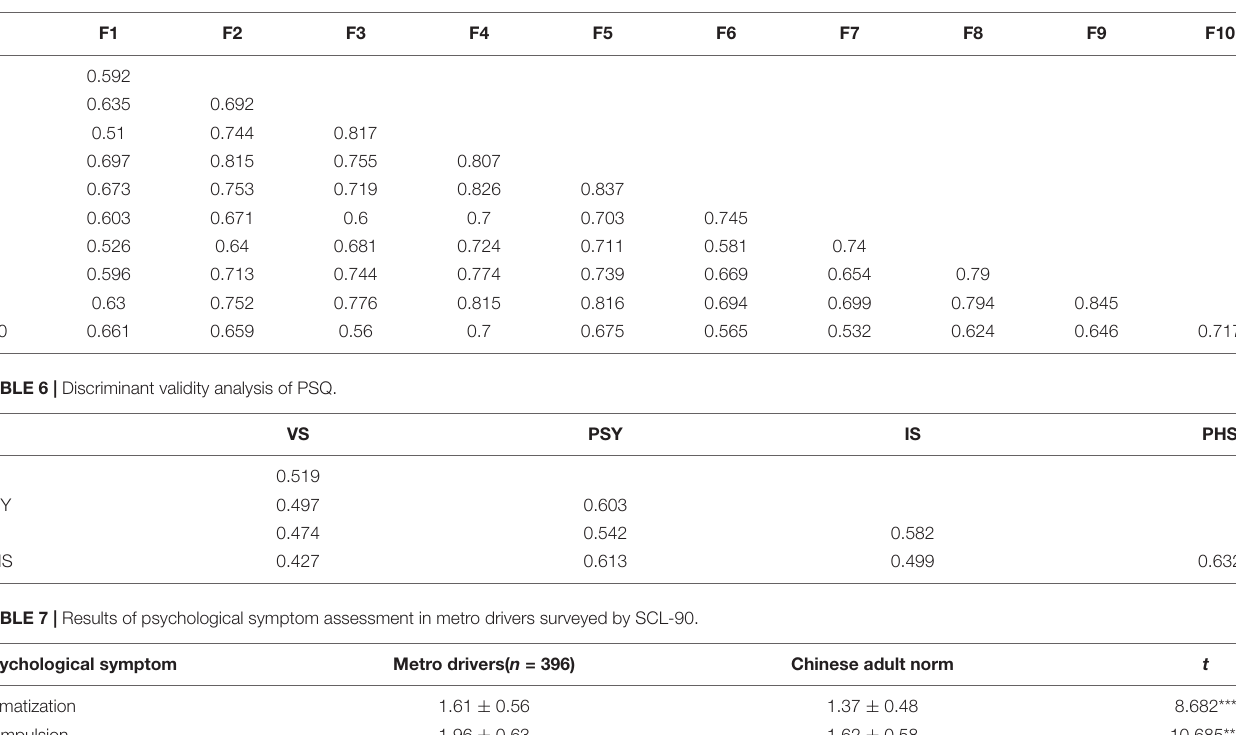
TABLE 5 | Discriminant validity analysis of SCL-90.